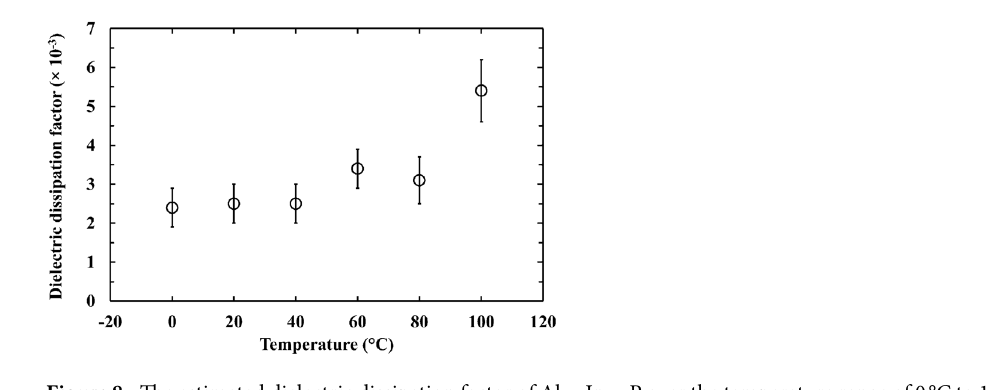
Figure 8. The estimated dielectric dissipation factor of Al 0.52 In 0.48 P over the temperature range of 0 °C to 100